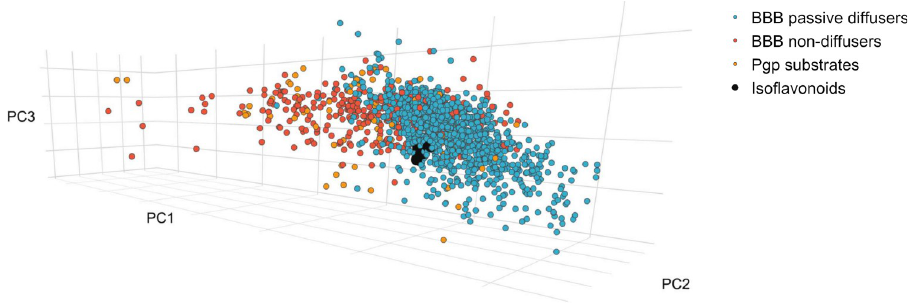
Fig 4. The location of BBB passive diffusers (blue), non-diffusers (red), P-glycoprotein substrates (orange) and isoflavonoids (black) in chemical space.